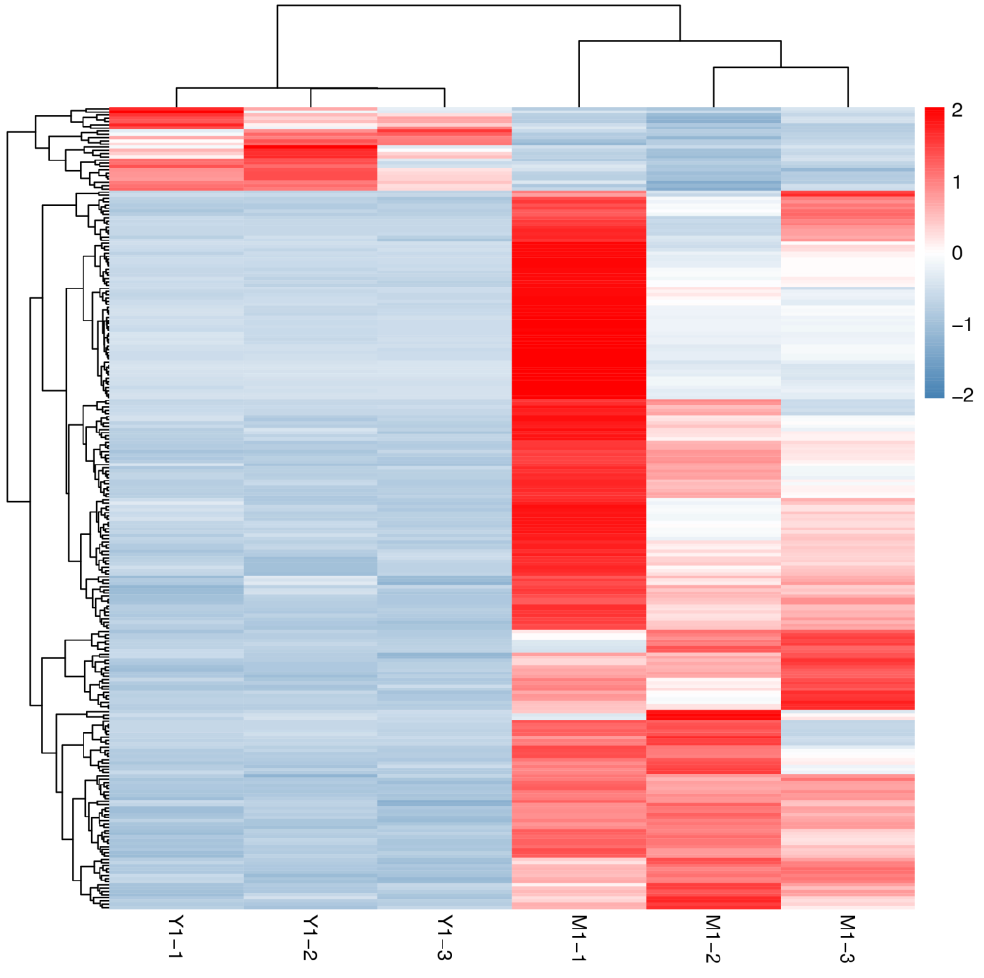
Figure 4. Comparison of differentially expressed genes in a heat map.